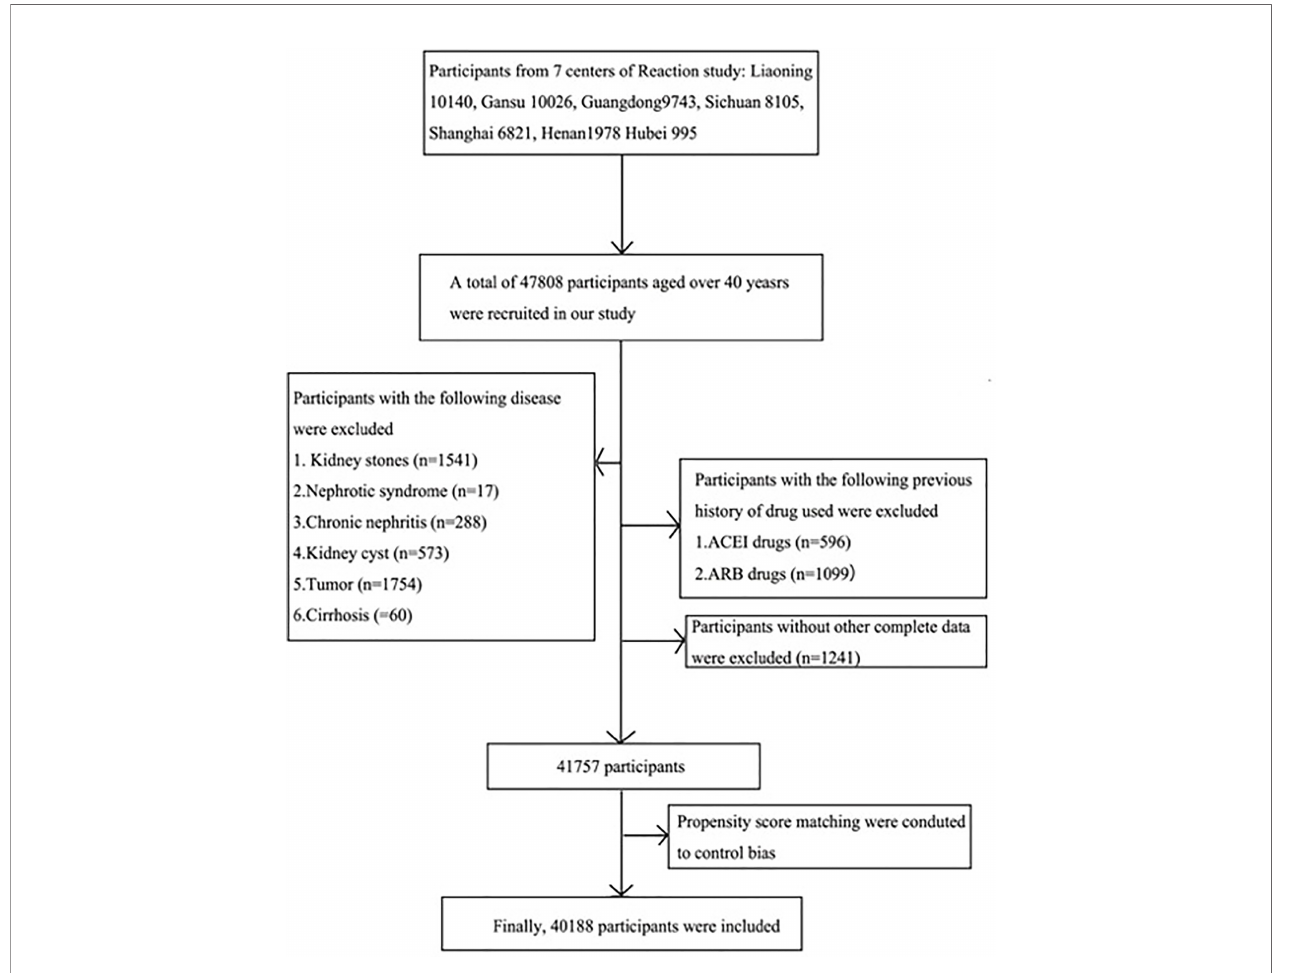
FIGURE 1 | Flowchart of the selection of study